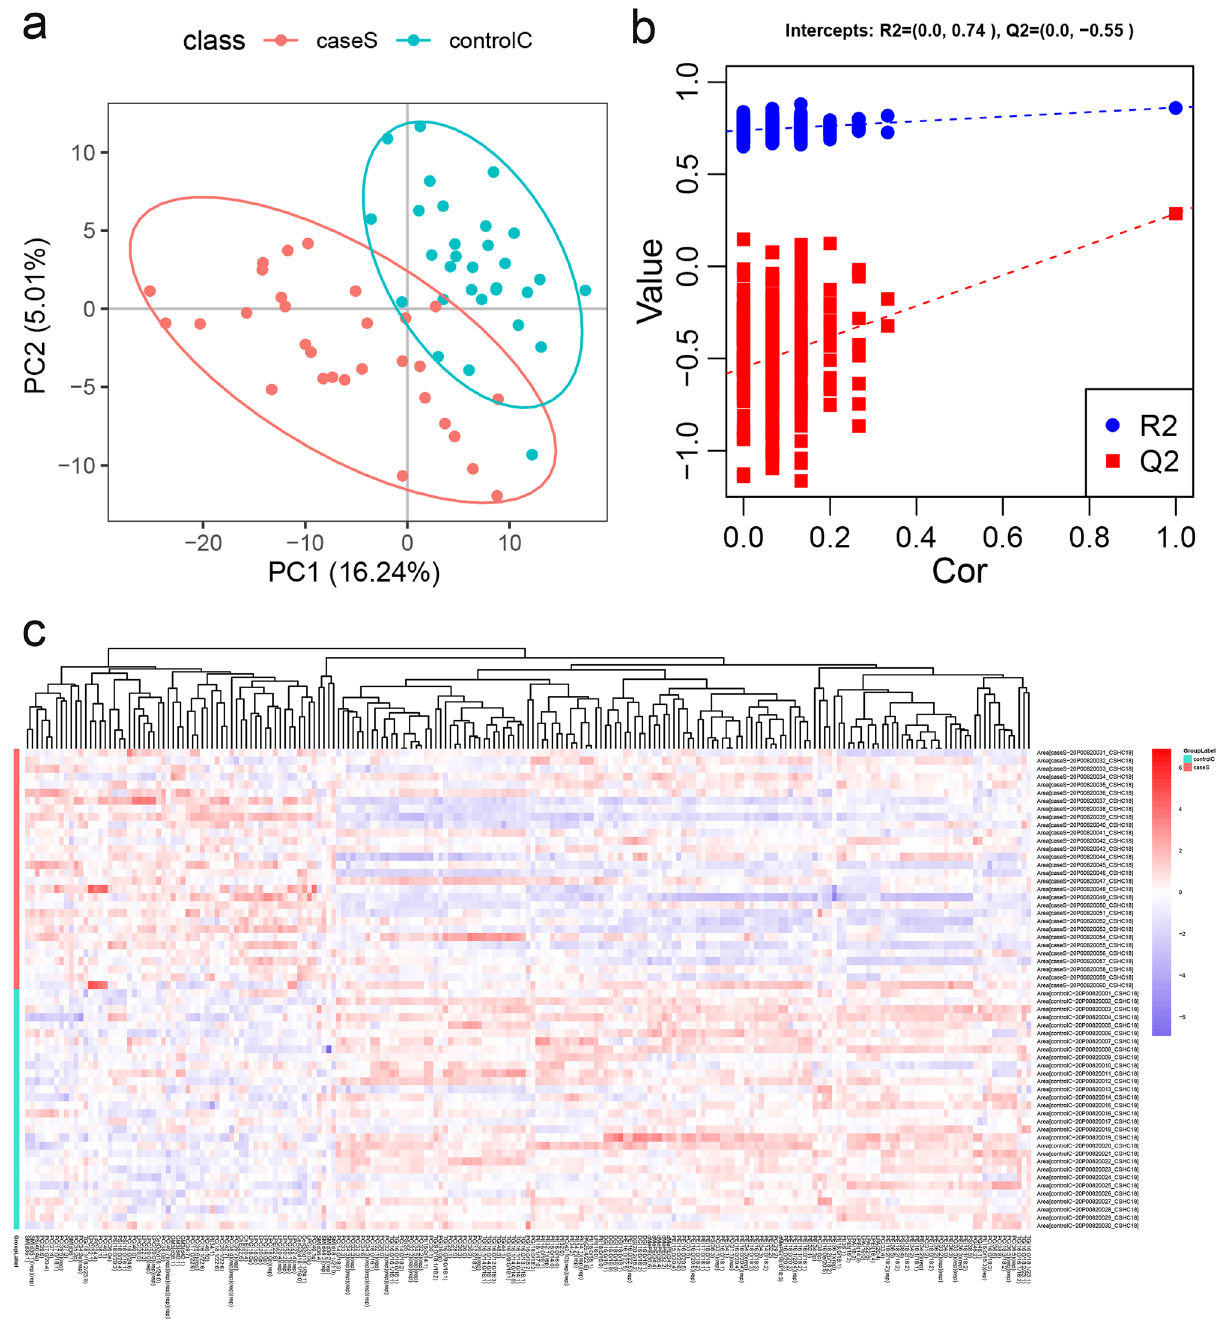
Figure 1. Difference analysis for the SCH group and the control group. ( a ) The PLS-DA model score plot; ( b ) response sequencing test plot of the PLS-DA analysis model. ( c ) The cluster analysis diagram shows the aggregation trend in lipid profile between the SCH and control groups. (Note: One point in ( a ) corresponds to one sample, green represents the control group, and red represents the SCH group. Each column in ( c ) represents a differential ion, and each row represents a sample. The different shades of color indicate the intensities, of which the blue indicates low-intensity and red significant. For the pregnancy outcomes of subjects in the two groups, the differences in neonatal sex and Apgar scores at 1 and 5 min were also not significant. However, birth weight (BW) was significant ( p = 0.036). Difference analysis for the SCH group and the control group. To validate the significant differences between the SCH group and the control group, the supervised partial least squares–discriminant analysis (PLS- DA) multivariate method was used to remodel and analyze the two groups of data (Fig. 1a). The results showed that most members of the two groups could be separated (R2Y-0.862 and Q2 = 0.286). In model validation